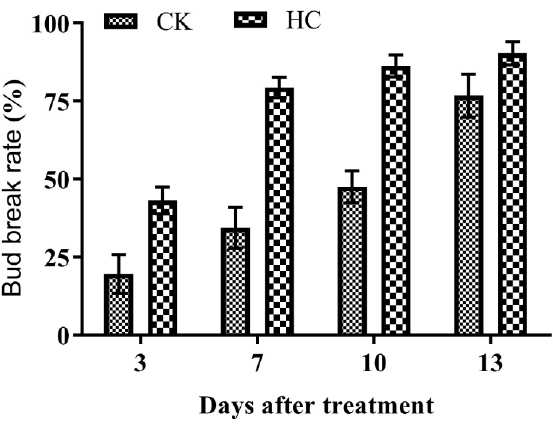
Figure 1. Bud break responses of the HC treatment (HC) and the control (CK) at 3, 7, 10, and 13 days after treatment. Bars represent ± SEM of three biological replicates.